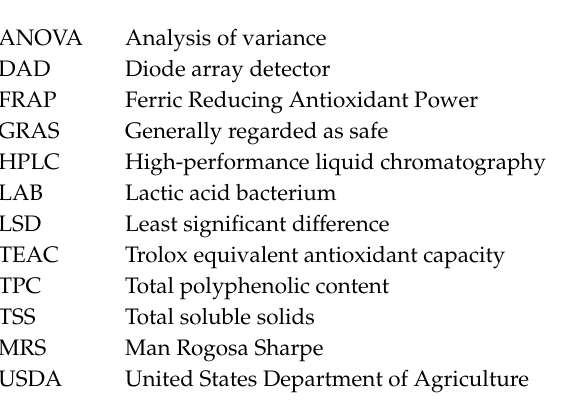
Figure S1: Chromatogram showing the changes in gallic acid concentration and pyragallol during fermentation by Weissella cibaria (strain 21 ) and Lactobacillus plantarum (strain 75 ), Table S1: Pearson’s correlation coe ffi cients of phenolic profiles and antioxidant (FRAP)